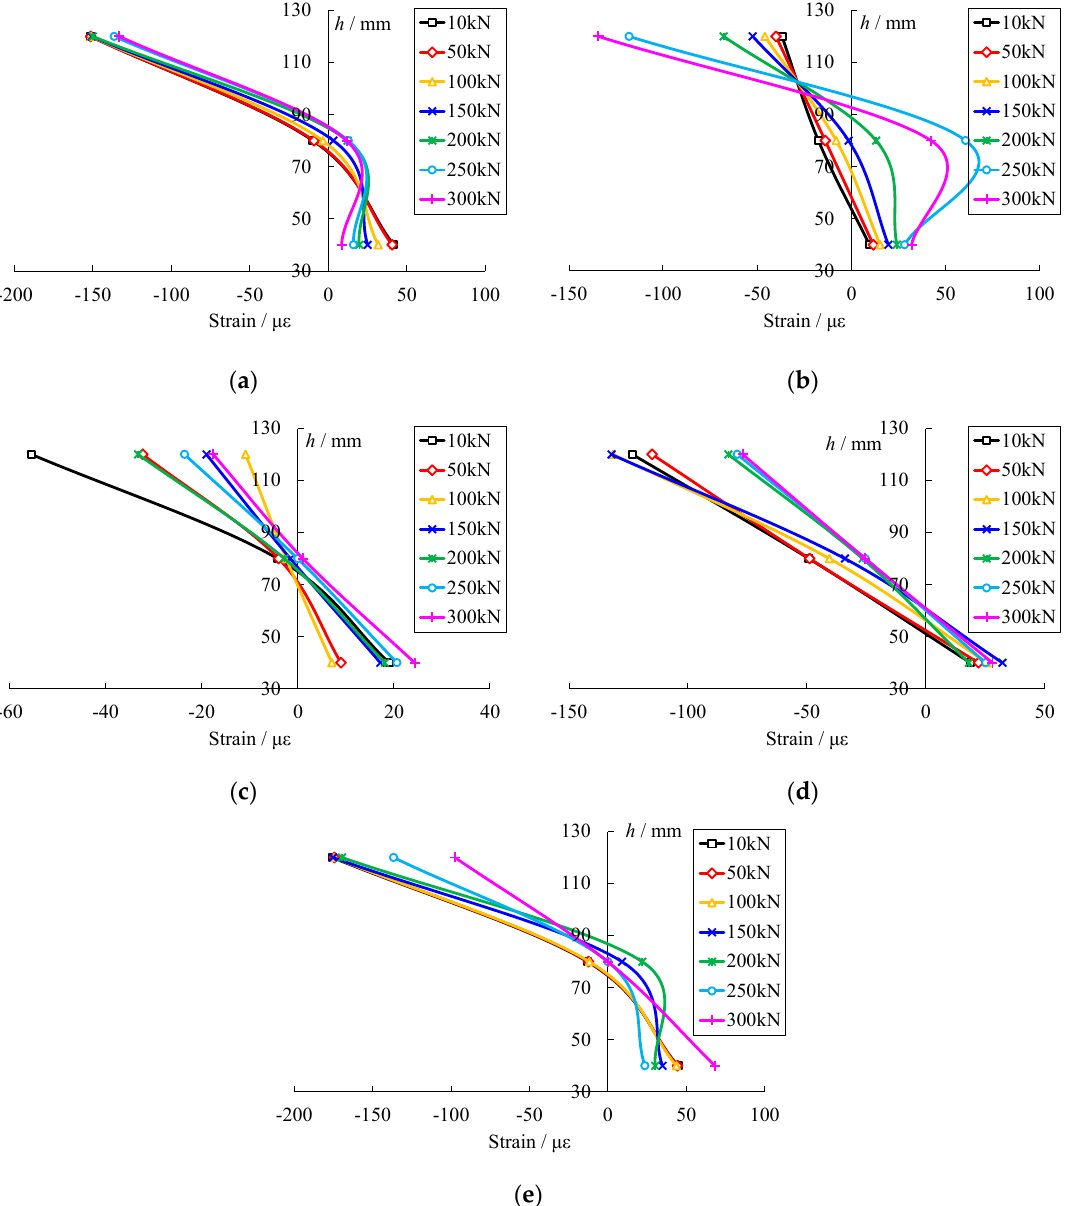
Figure 10. Strain distribution at mid-span section. ( a ) WS beam; ( b ) ZSS1 beam; ( c ) ZSS2 beam; ( d ) DSS2 beam; ( e ) DSS3